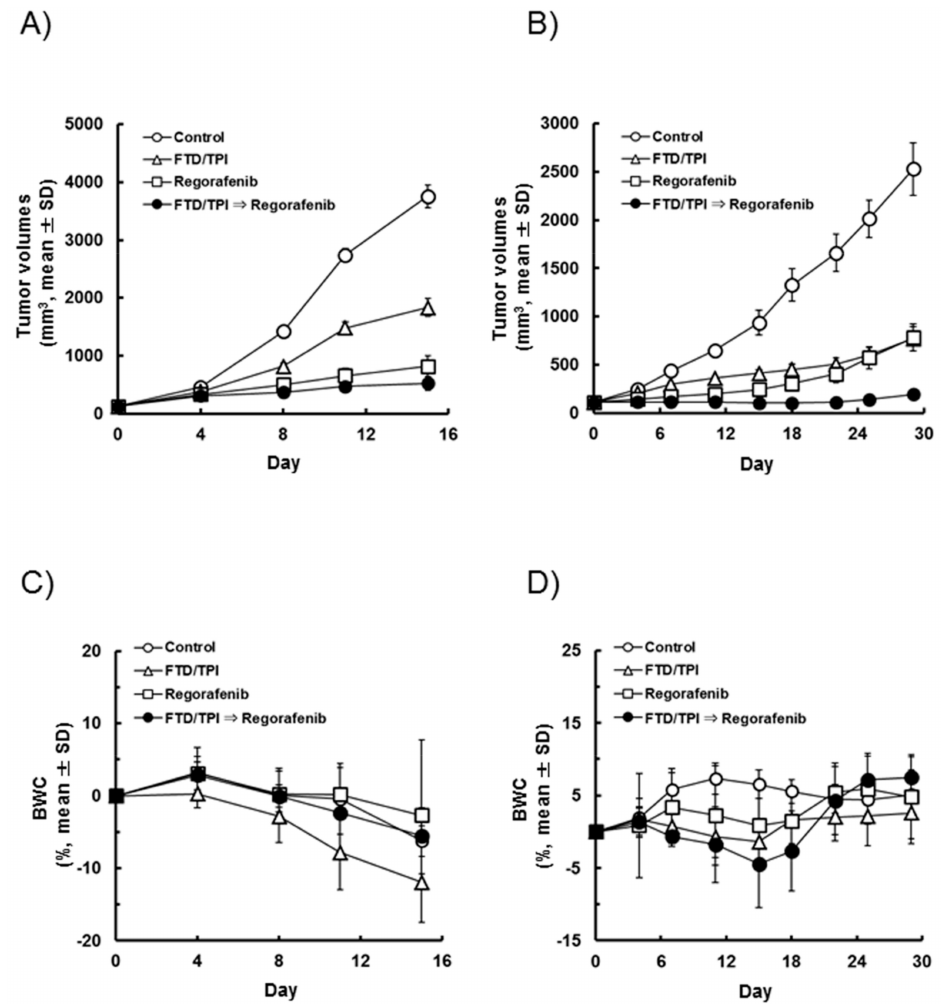
Figure 4. Tumor volume and body weight changes (BWC) in SW620 and COLO205 xenografted mice after daily oral sequential administration of trifluridine/tipiracil (FTD/TPI) and regorafenib. Xenografted mice were randomized on day 0. FTD/TPI (150 mg/kg) and regorafenib (10 mg/kg) were administered orally twice and once daily, respectively, from days 1 to 14. ( A , B ) Tumor volume changes and ( C , D ) body weight changes in SW620 and COLO205 xenografts, respectively. Values indicate mean ± SD ( n =